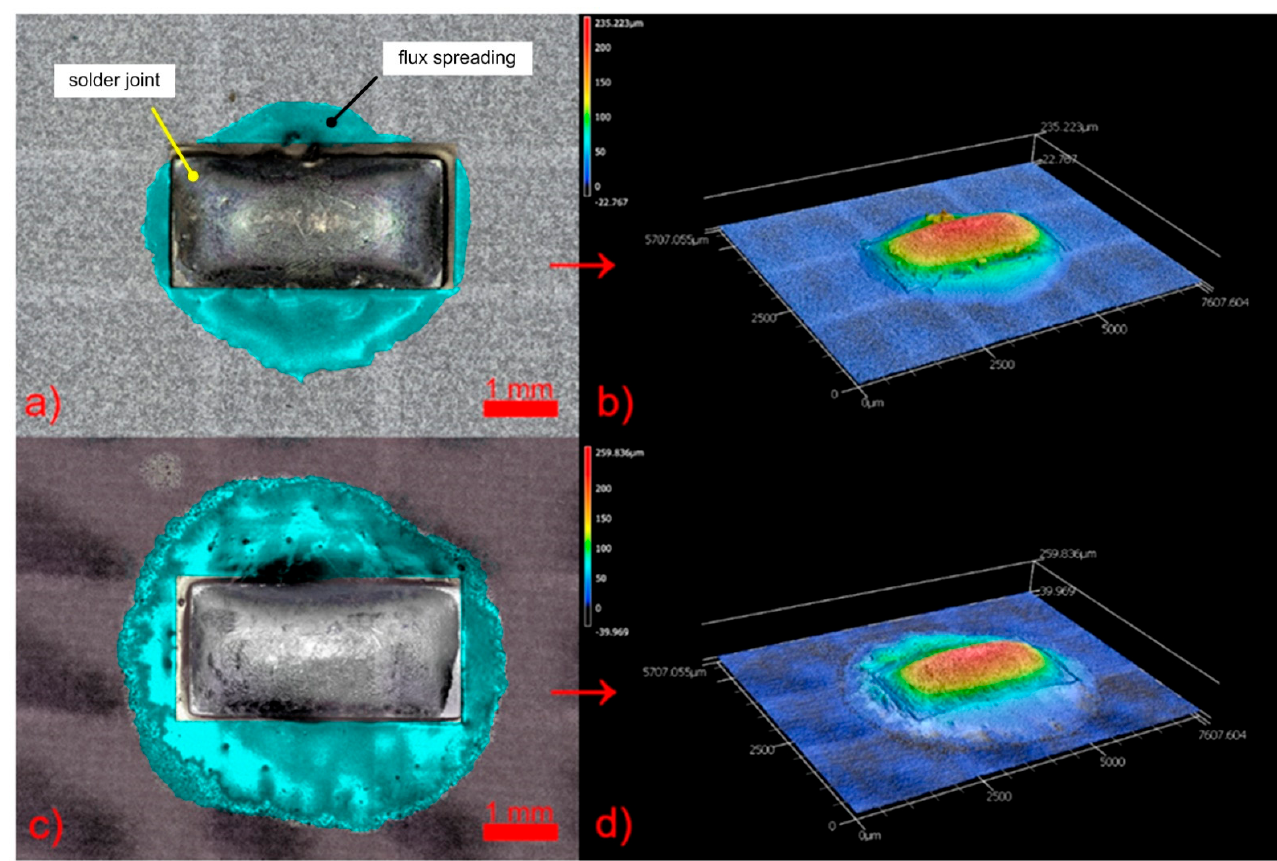
Figure 9. Analysis of flux spreading by the 3D laser confocal microscope. Solder joint on glossy (white) mask ( a ) and its 3D scan ( b ); solder joint on matt (black) mask ( c ) and its 3D scan ( d ). The volume of the flux was measured only in the highlighted area (cyan color)—shown in ( a ) and ( c ).